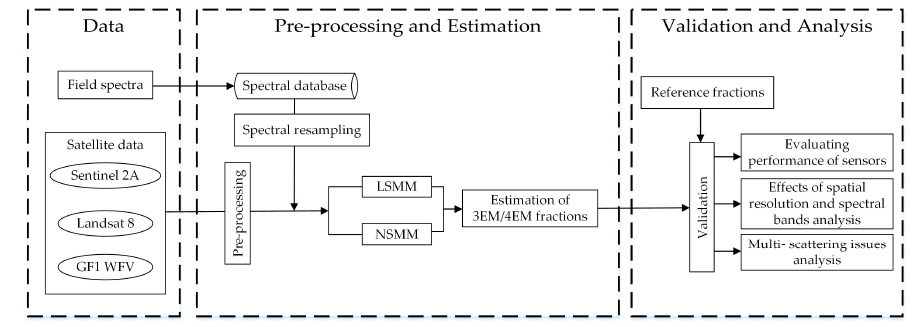
Figure 4. Workflow diagram of methodology and analysis process.